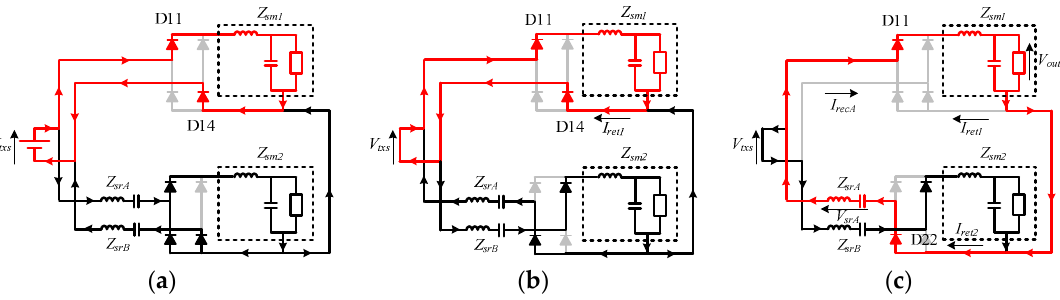
Figure 11. Current path of experimental circuit in each operation mode (the red line indicates the path related to Lout1): ( a ) Mode 2; ( b ) Mode 7; ( c ) Mode 10.